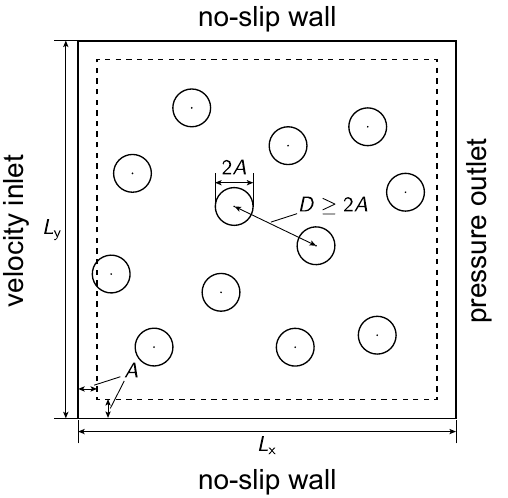
Figure 1. Schematic diagram of the analysis domain defined in the present study. The circles represent cylinders and the dashed square represents the region in which the center of each cylinder